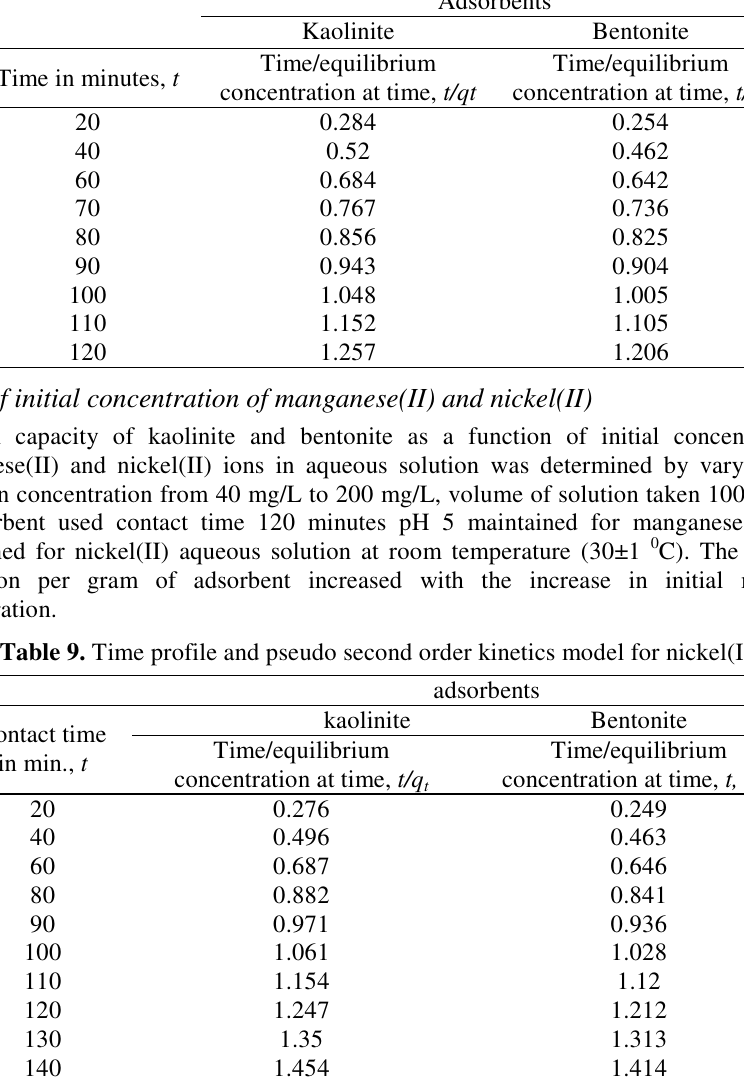
Table 8 . Time profile and pseudo second order kinetics model for manganese(II) Adsorbents Kaolinite Bentonite